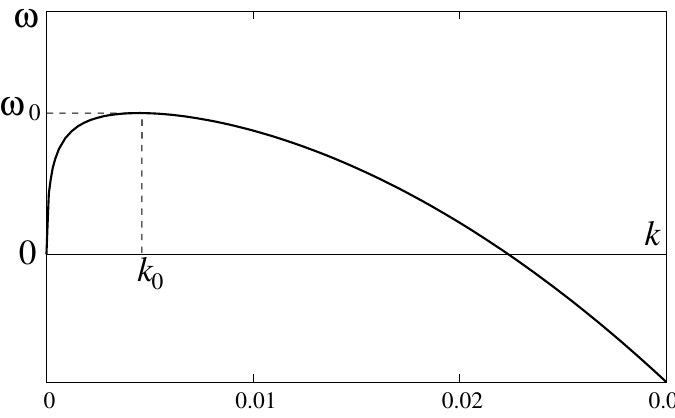
Figure 1. Dispersion relation ω ( k ) defined by Equation (1); G = 0.002, k 0 = 0.0045, ω 0 =